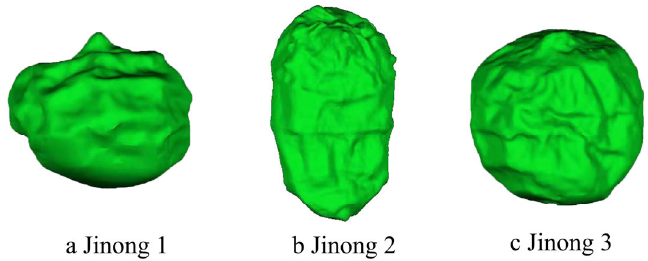
Figure 3. ( a – c ) The outer shapes of the Cyperus esculentus seeds. Seven ‐ , 9 ‐ and 11 ‐ sphere models of Jinong 1 were successively modeled, as shown in Figure 4a–c. 9 ‐ , 11 ‐ and 13 ‐ sphere models of Jinong 2 were successively modeled, as shown in Figure 5a–c. 7 ‐ , 9 ‐ and 11 ‐ sphere models of Jinong 3 were modeled, as shown in Figure